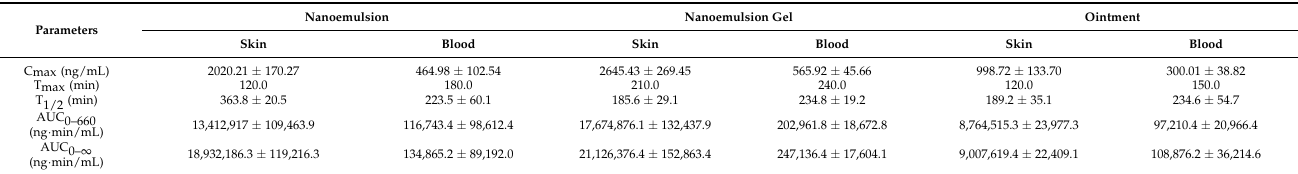
Figure 2. Triptolide concentration–time courses in skin ( A ) and blood ( B ). Table 3. Pharmacokinetic parameters in skin and blood after three triptolide delivery system admin- istrations (mean ± SD).